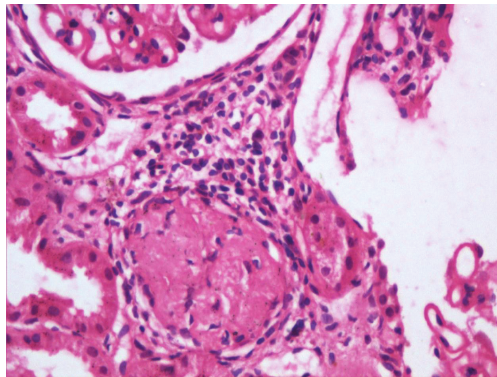
Figure 1: Acid fuchsin or Masson’s trichome staining showing reddish coloured deposits on basement membrane.